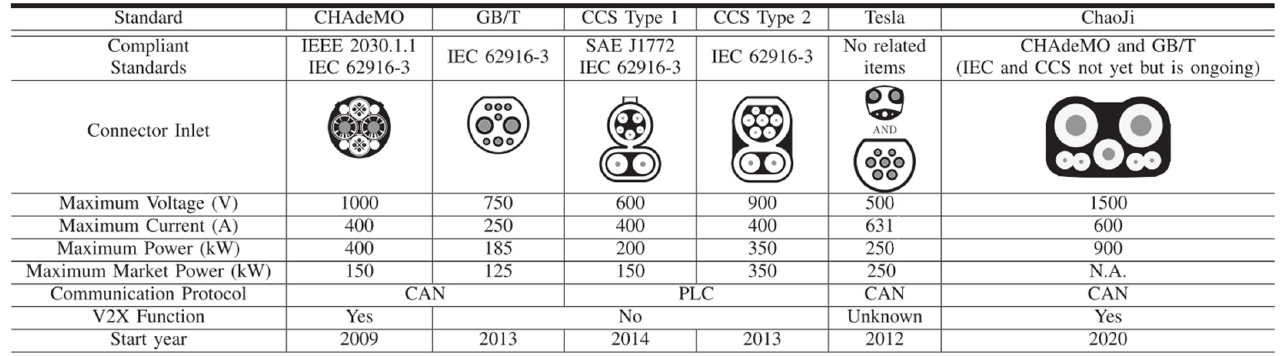
Figure 1. Overview of fast charging standards. (Adapted from Ref. [11].)